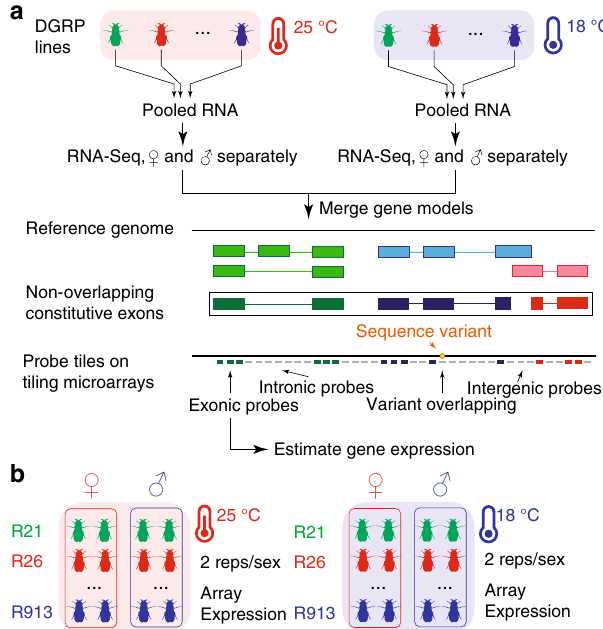
Fig. 1 Experimental design and gene expression estimation strategy. a RNA extracted from adult fl ies raised at 25 and 18 °C from all DGRP lines was pooled and sequenced to de fi ne a set of nonoverlapping constitutive exons. Genome tiling arrays were then used to estimate gene expression, summarizing expression based on intensities of probes that fall entirely within constitutive exons and do not overlap with common sequence variants. b DGRP lines were raised at 25 and 18 °C and RNA was extracted from adult fl ies for two biological replicates per sex within each temperature. Gene expression was estimated using genome tiling